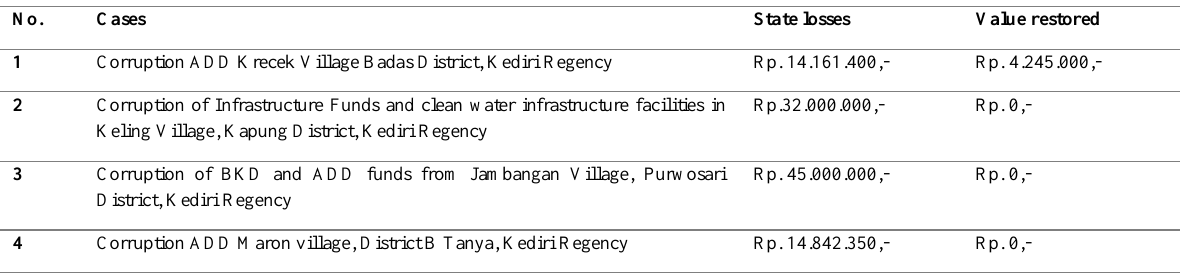
the loss is less than IDR 50,000,000